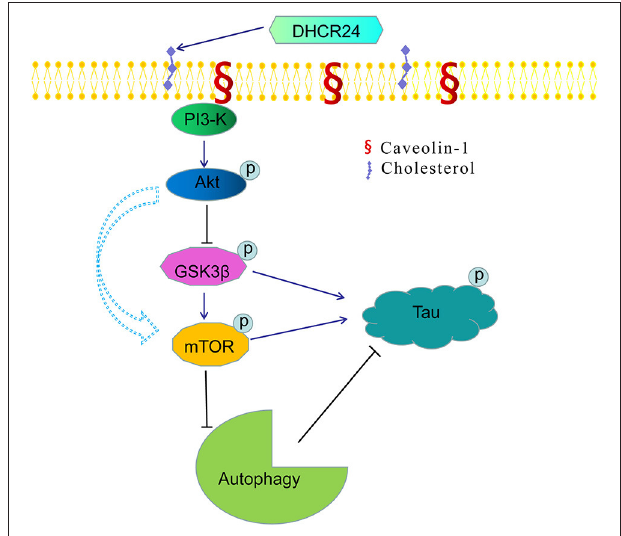
FIGURE 7 | A bridge connecting cholesterol and AD: knock-down of DHCR24 mediated disregulation of cholesterol homeostasis in regulating tau hyperphosphorylation and autophagy. DHCR24 knock-down could lead to the abnormality of membrane lipid raft structure and function, then in turn resulting in the inhibition of lipid raft-dependent PI3-K/Akt signaling. Moreover, it also enhanced the activation of GSK3 β and mTOR signaling by lipid raft-dependent PI3-K/Akt signaling. In addition, DHCR24 knock-down obviously induced tau hyperphosphorylation and inhibition of autophagy by the overactivation of GSK3 β and mTOR signaling via lipid raft-dependent PI3-K/Akt signaling, which are involved in the pathogenesis of